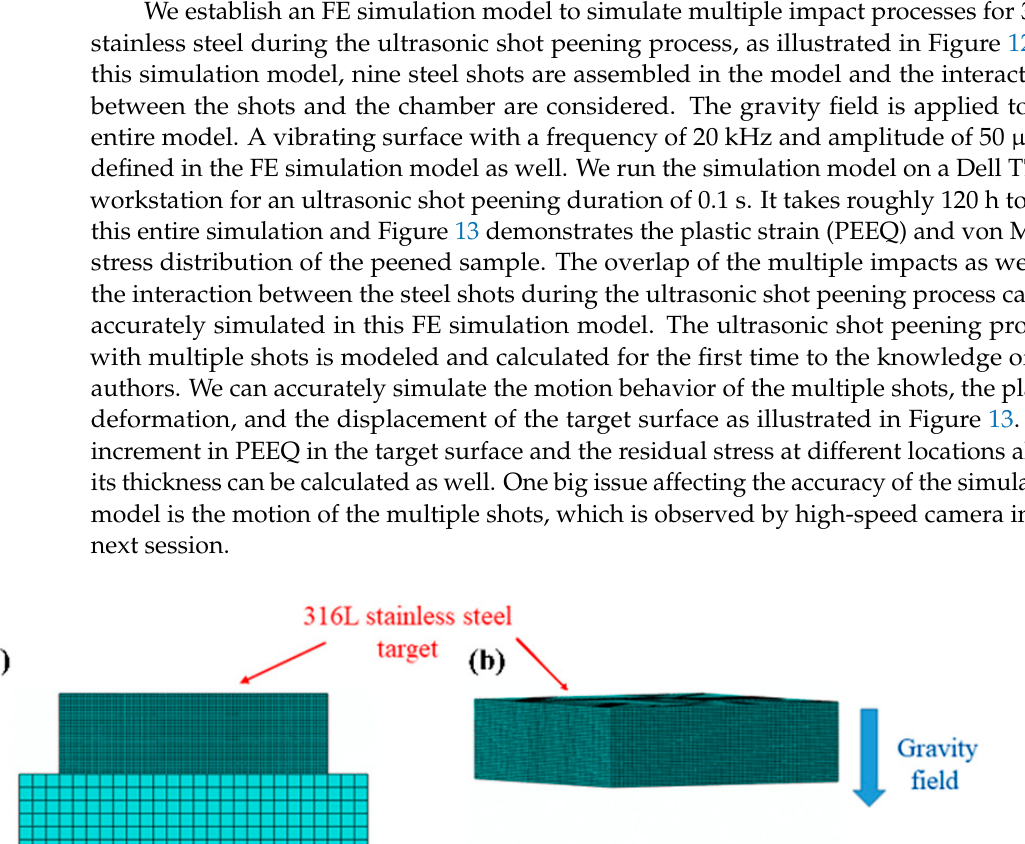
Figure 13. FE simulation of ultrasonic shot peening process of 316L stainless steel with multiple shots for a duration of 0.1 s: ( a ) plane view of PEEQ distribution of 316L stainless sample; ( b ) cross- sectional view of PEEQ distribution of 316L stainless sample; ( c ) plane view of von Mises stress distribution of 316L stainless sample; ( d ) cross-sectional view of von Mises stress distribution of 316L stainless sample; ( e ) accumulated PEEQ with time during the peening process for the four points marked in ( a ); and ( f ) the residual stress distribution of the peened 316L stainless steel along the four paths marked in ( d ). The motion of the multiple shots is captured by the high-speed camera with fps of 10,000, as illustrated in Figure 14. Due to the interaction between the multiple shots, we identified a “relay” effect of the impact during the ultrasonic shot peening process. The collision between the shots with high velocity can shorten the working distance to increase